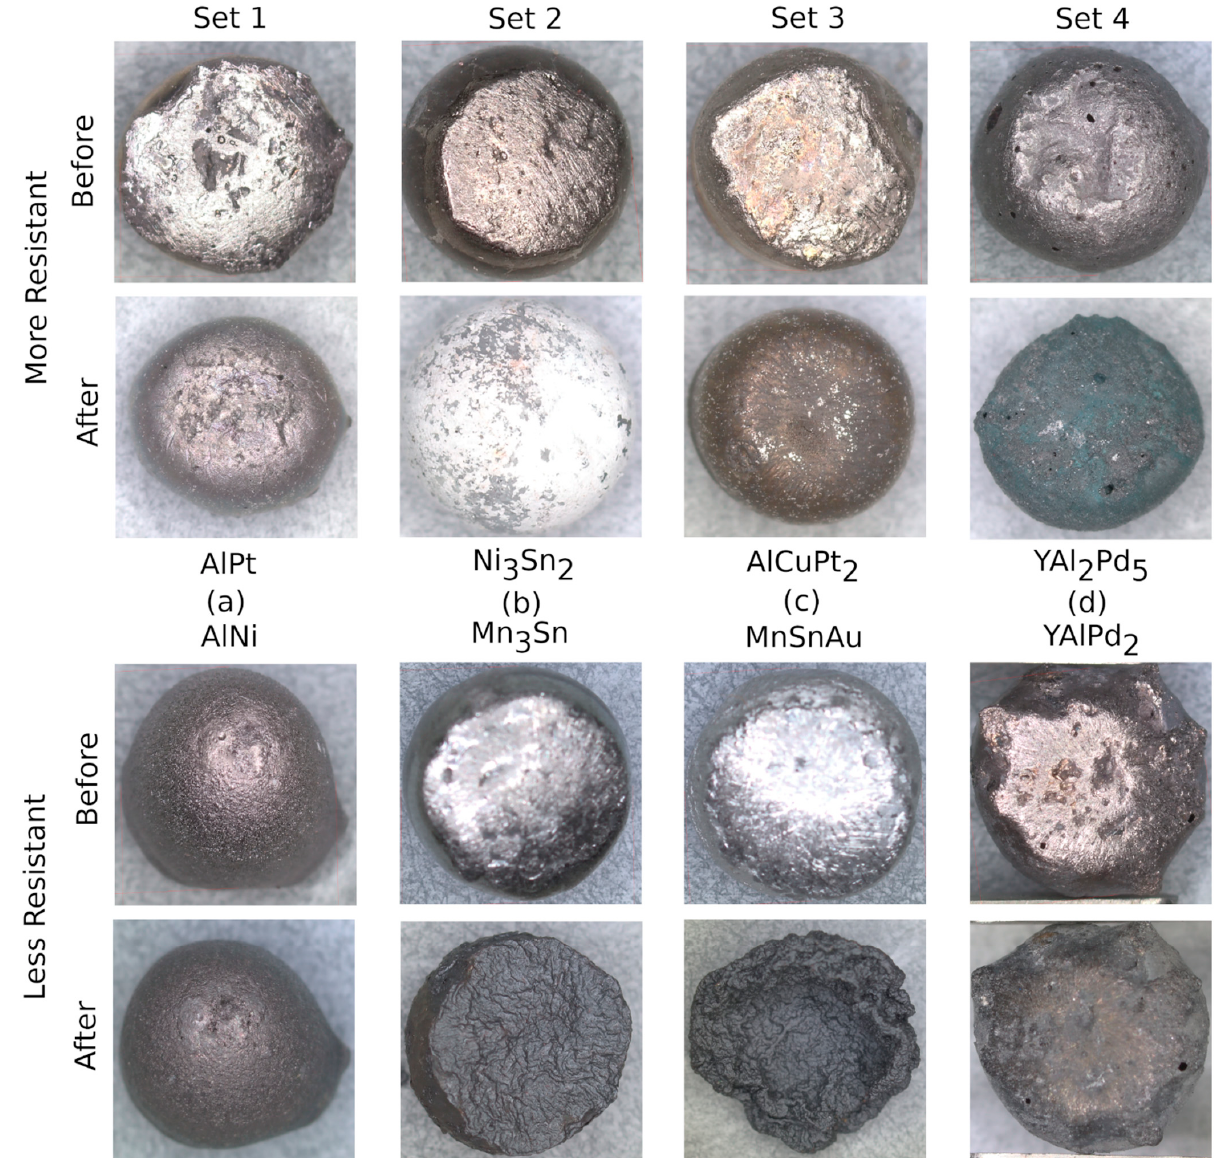
Figure 1. Optical images of surfaces of paired binary and ternary compounds, comparing predicted oxidation resistance to that found experimentally for ( a ) AlPt-AlNi, ( b ) Ni 3 Sn 2 -Mn 3 Sn, ( c ) AlCuPt 2 - MnSnAu, and ( d ) YAl 2 Pd 5 -YAlPd 2 . “Before” and “After” refer to before and after controlled oxidation, respectively (see Section 2). In general, trends within each matched set are in good agreement, with the “less resistant” alloy showing more oxidation, with the exception of the Pd-containing ternaries (set